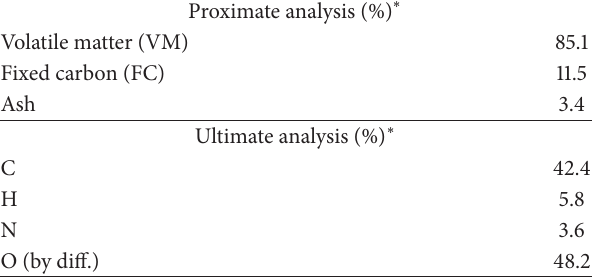
Table 1: Ultimate and proximate analysis of OPF